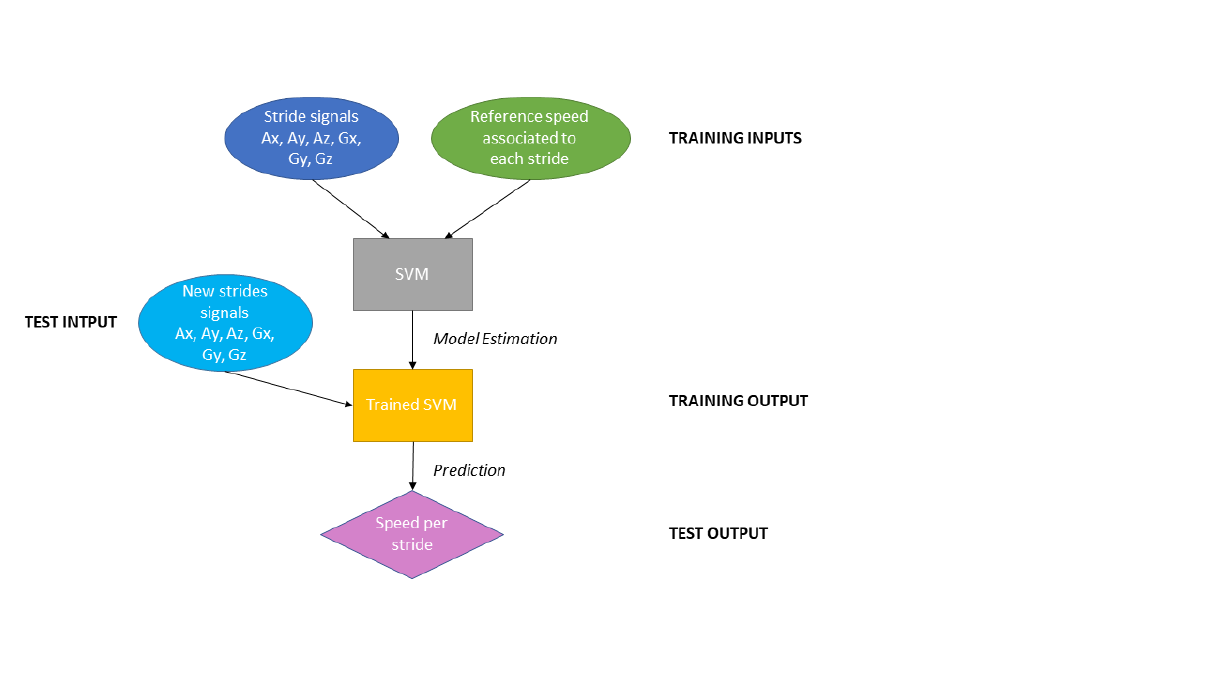
Figure 5. Diagram of the SVM process from training to the speed